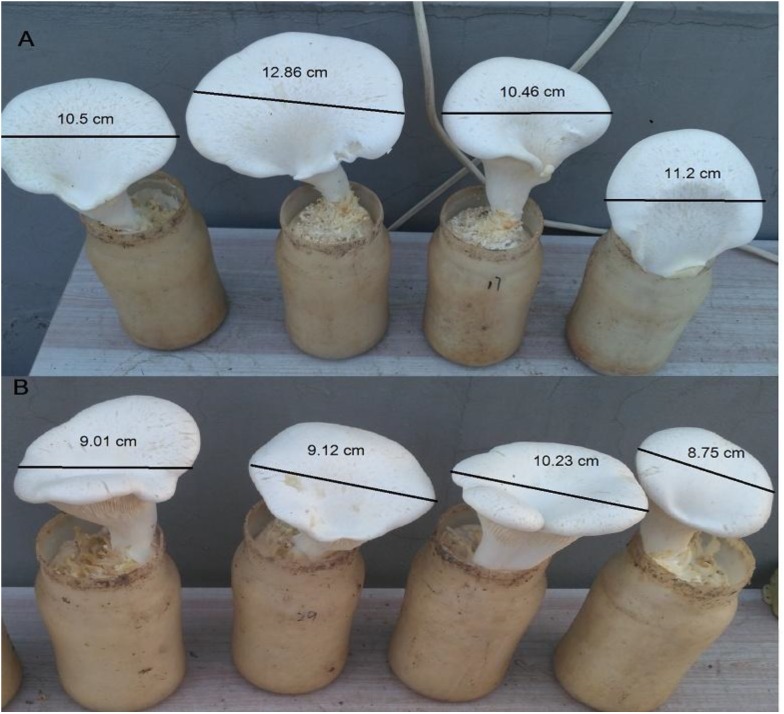
The diameter of fruiting body after a MPMP of 35 days at 17°C (A) and 29°C (B), separately.